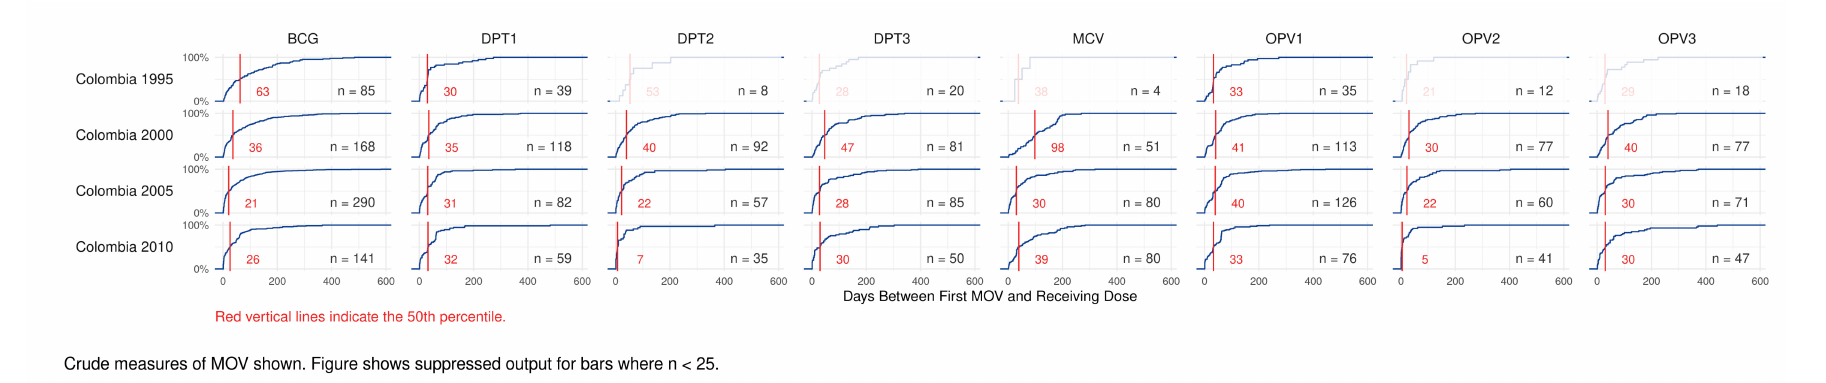
Figure 6. Cumulative distribution of time to MOSV correction, in days, by dose, Nigeria 1990–2018. Additional quantiles for Nigeria are documented in supplementary Table SN.5a and subnational detail is in Table SN.5b.